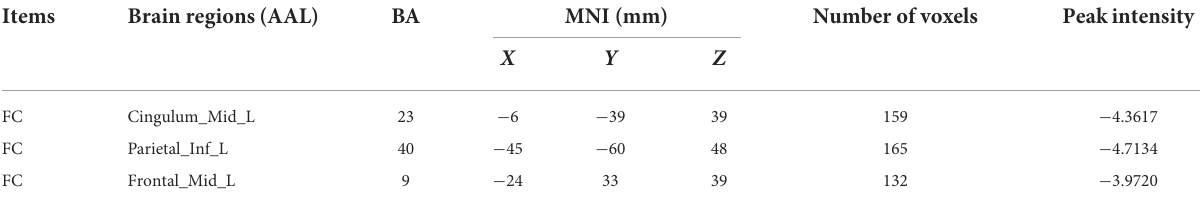
TABLE 7 Anatomical Locations of Significant Main Effect of Group on mOFC-based FC of mOFC and SMG.